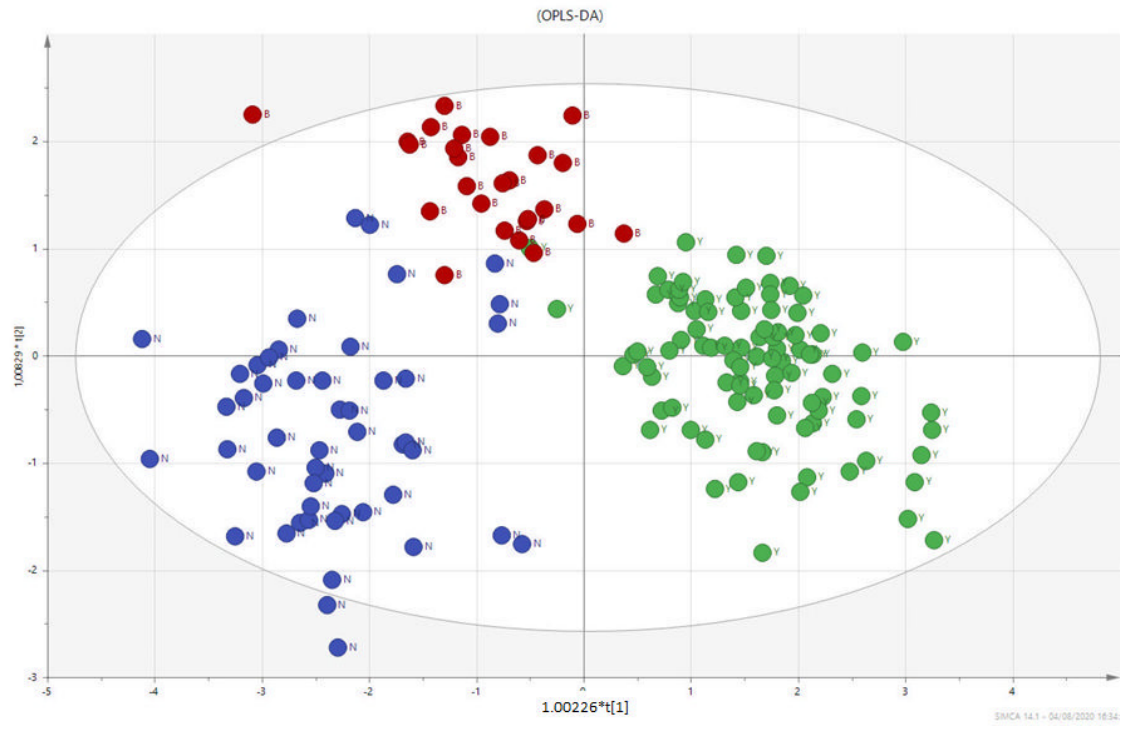
Figure 2. PLS-DA score plots derived from the LC-HRMS spectra of plasma and corresponding coefficient loading plots obtained from the three groups—PC (GREEN), PL (RED), and BPH